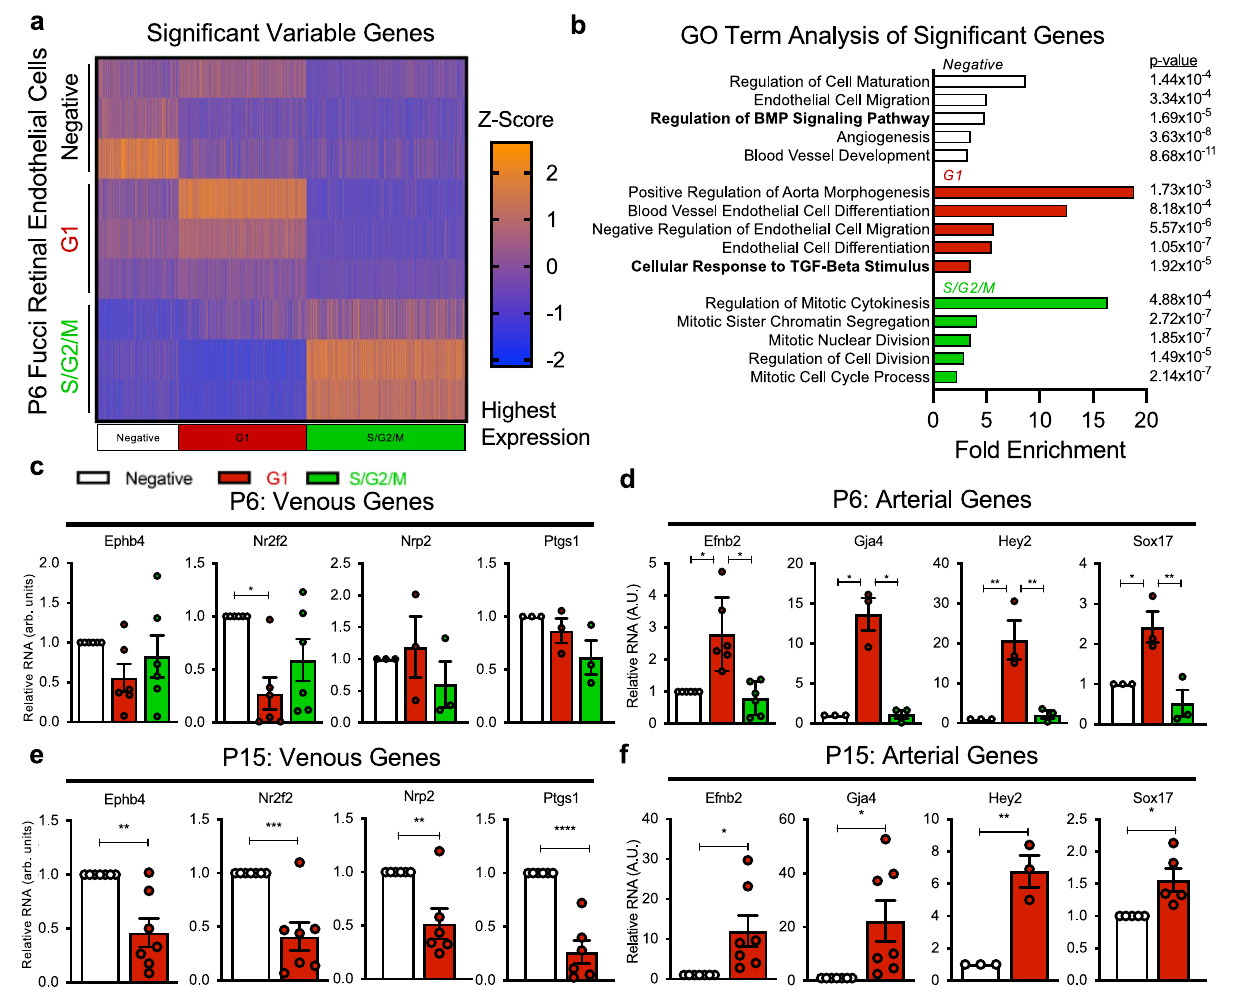
Fig.2|GeneexpressionanalysisofdevelopingretinalendothelialcellsinFUCCI cell cycle states. a All signi fi cantly variable genes within different cell cycle states fromP6R26FUCCI2aRretinalendothelialcellsfromRNAsequencing,eachcolumnof heatmap shows Z-score of a single gene with enrichment in each cell cycle state highlighted by highest expression. b GO term enrichment analysis of genes upregu- lated in FUCCI-Negative state, FUCCI-Red G1 state or FUCCI-Green S/G2/M states (statistical analysis reported from GO enrichment pipeline as p -value). c – f